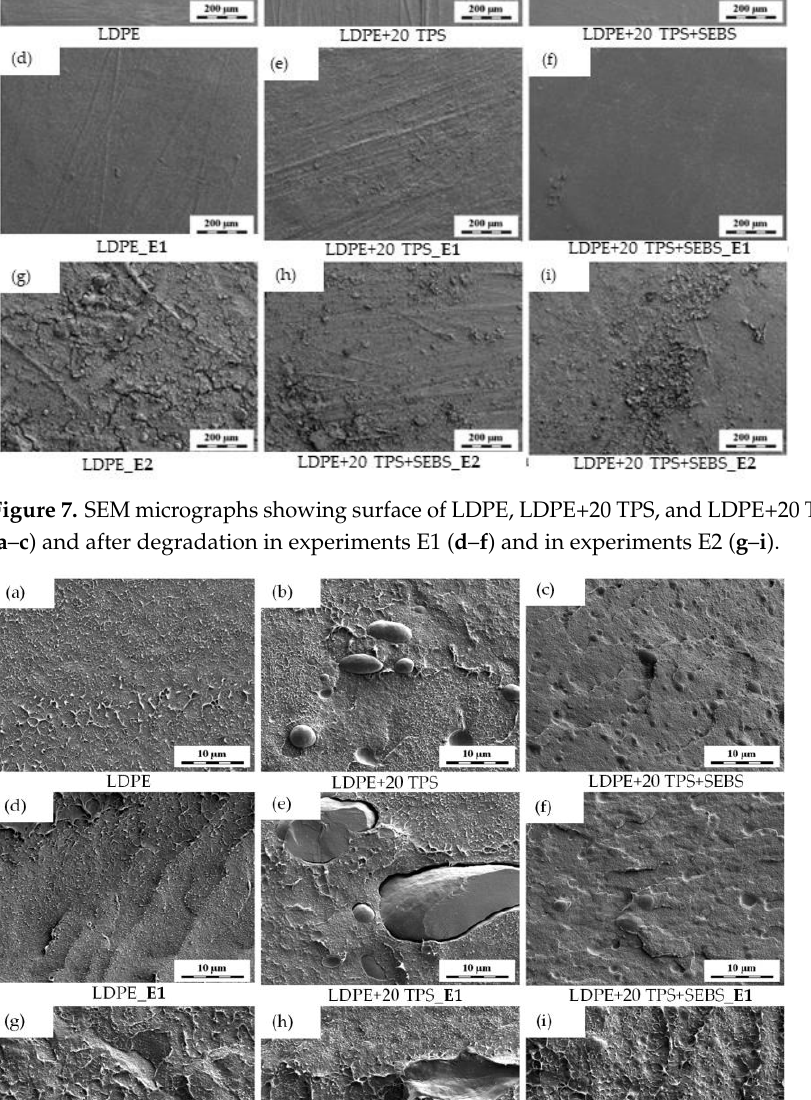
dation (dashed lines) and after degradation (full lines) in experiments E1 and E2. All